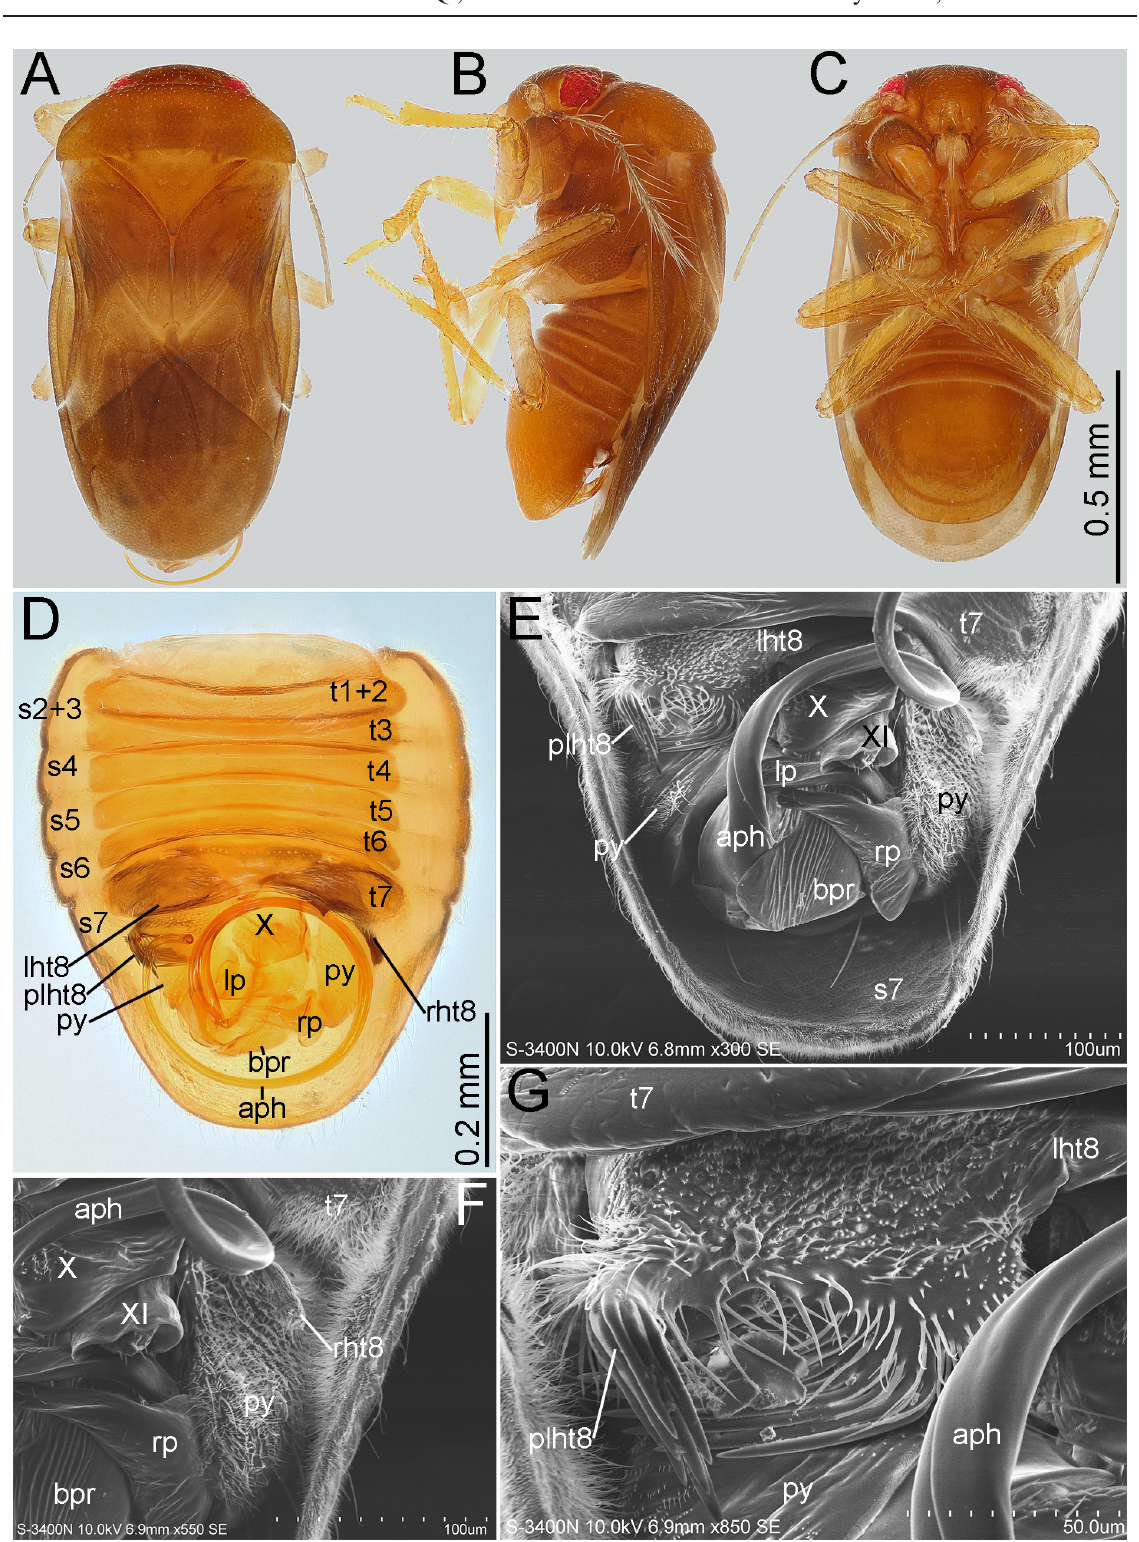
Fig. 11. Kokeshia hilli sp. nov. A‒C . Habitus, holotype, ♂ (NKUM). A . Dorsal view. B . Lateral view. C . Ventral view. D . Pregenital abdomen and genitalia, dorsal view, paratype, ♂ (SYSBM). E‒G . Scanning electron micrographs of genitalia, paratype, ♂ (SYSBM). E . Dorsal view. F . Right side, dorsal view. G . Left side, dorsal view. Abbreviations: see Material and